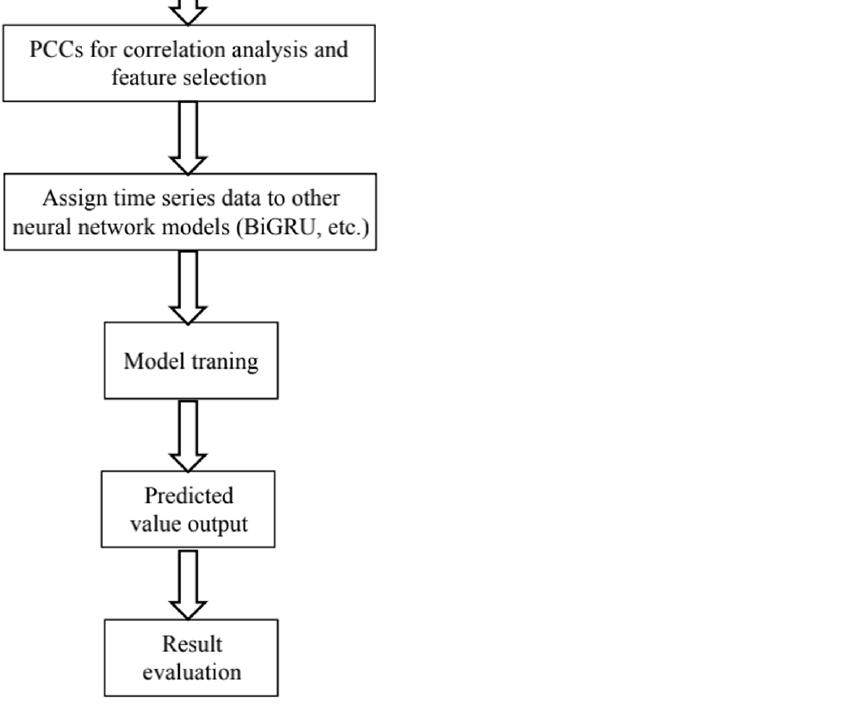
Figure 6. The flow chart of prediction based on PCCs and Bi-GRU neural network.